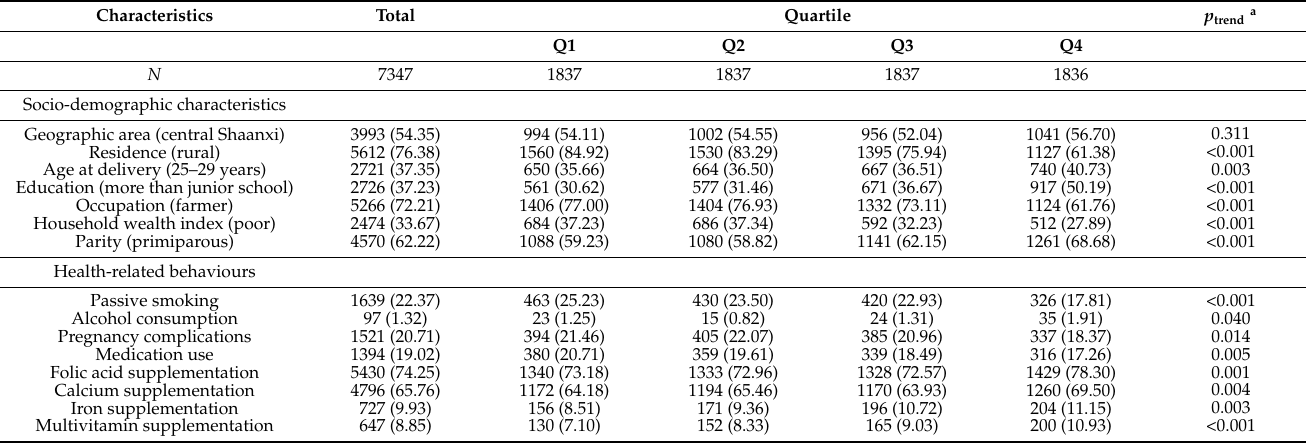
Table 2. Maternal characteristics according to quartiles of the high B-vitamin dietary pattern